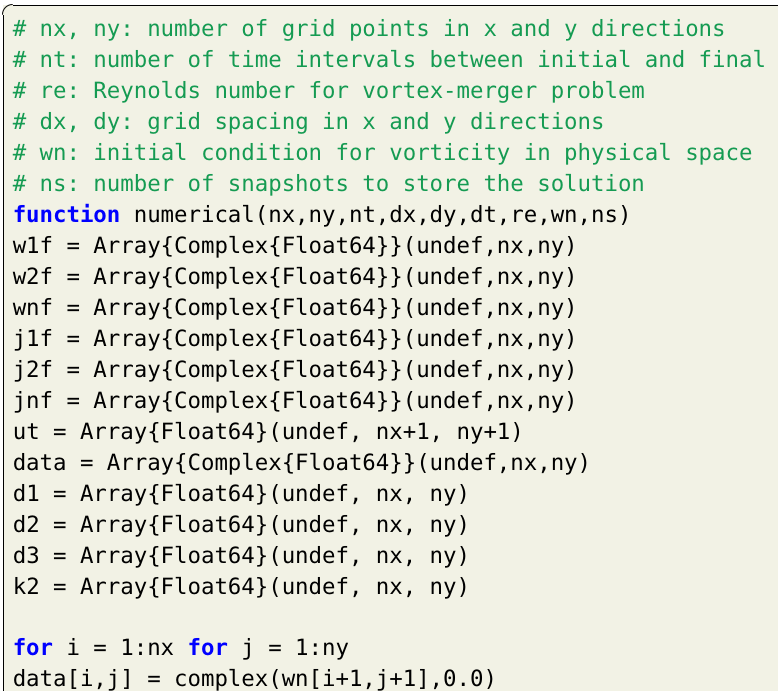
Listing 32. Julia implementation of hybrid third-order Runge-Kutta/ Crank-Nicolson scheme for 2D incompressible Navier-Stokes equation with Arakawa-spectral finite difference scheme.